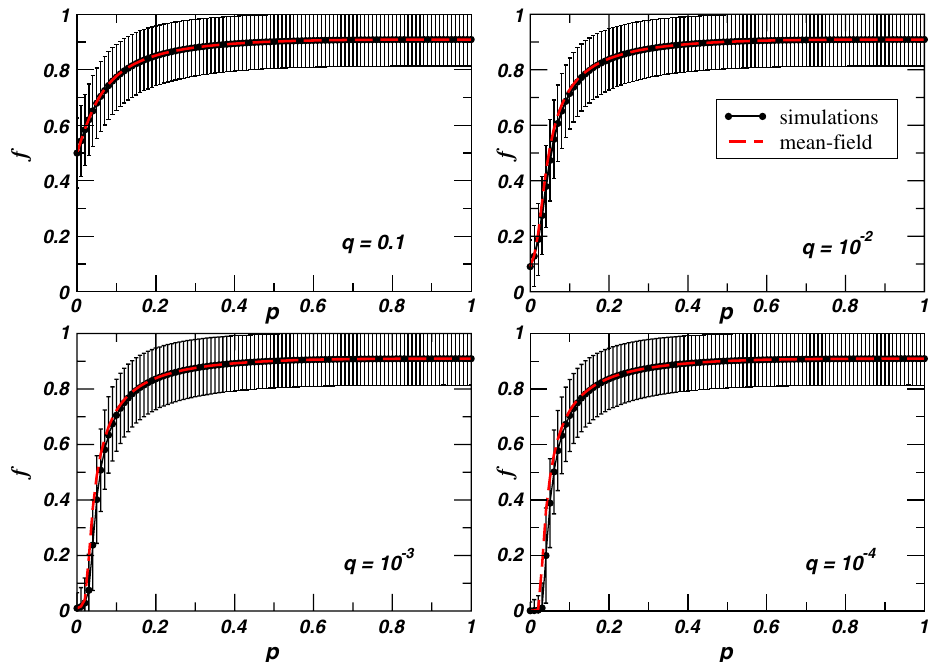
FIG. 2. Black circles represent the average density f of infected nodes in the stationary state ( τ ¼ 10 4 steps) of the SIS dynamics on a random regular graph of N ¼ 10 3 nodes and degree K ¼ 4 , as a function of the transmission probability p for q between 10 − 1 and 10 − 4 . The symmetric bars indicate the fluctuations around the average value computed on 10 4 realizations of the stochastic process. The red dashed line is computed from the solution of Eq.